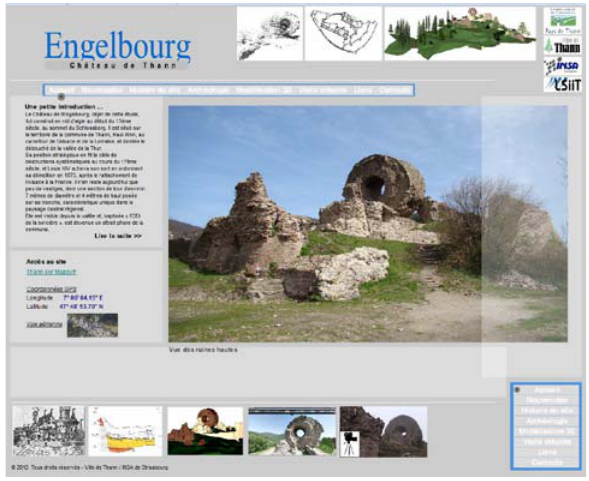
Figure 8. Website home